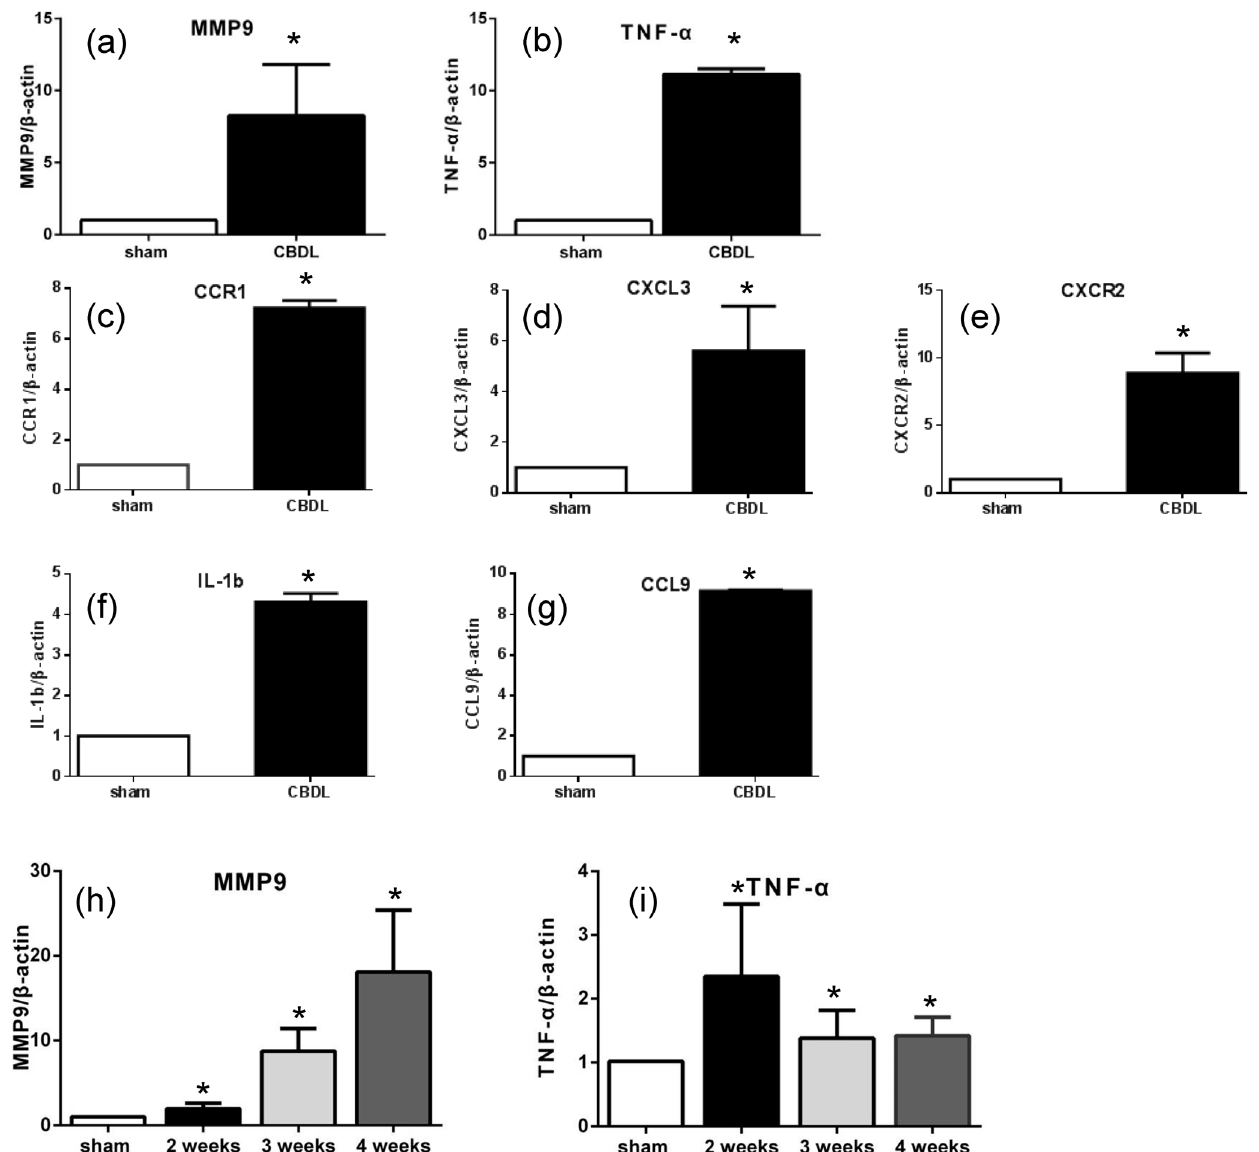
Figure 5. Real-time PCR analysis of representative genes identified with microarray analysis (a–g) was performed in pulmonary cells assembled by magnetic beads/CD31-antibody complexes in mice 3 weeks after CBDL (CBDL) and in sham operated controls (sham). (a) MMP9 and (b) TNF- a . (c) CCR1, (d) CXCL3, (e) CXCR2, (f) IL-1b, and (g) CCL9. (h) and (i) were performed in whole pulmonary cells of sham and 1–4 weeks after CBDL groups. (h) MMP9 and (i) TNF- a . Values are expressed as mean 6 standard error (n=3 in each group). Y-axis abbreviations: CCL9, chemokine CC motif ligand 9; MMP9, matrix metallopeptidase 9; TNF- a , tumor necrosis factor alpha; CCR1, CC chemokine type-1 receptor; CXCL3, chemokine CXC motif ligand 3; CXCR2, CXC chemokine receptor; IL-1b, interleukin-1 beta. *P , 0.05 (CBDL vs.